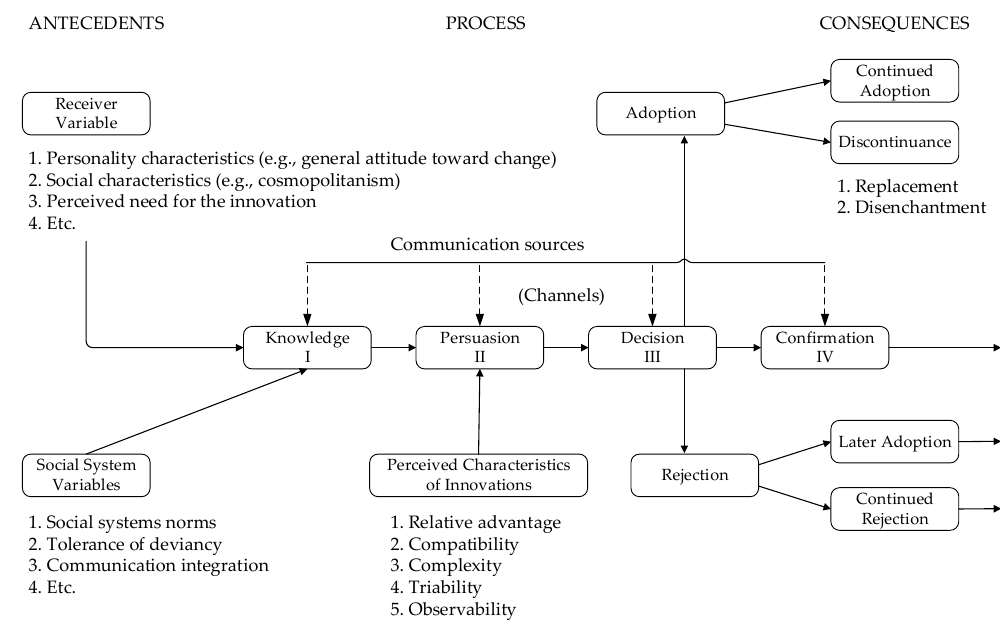
Figure 4. Model of Stages in the Innovation-Decision Process. Adapted from Rogers [18].